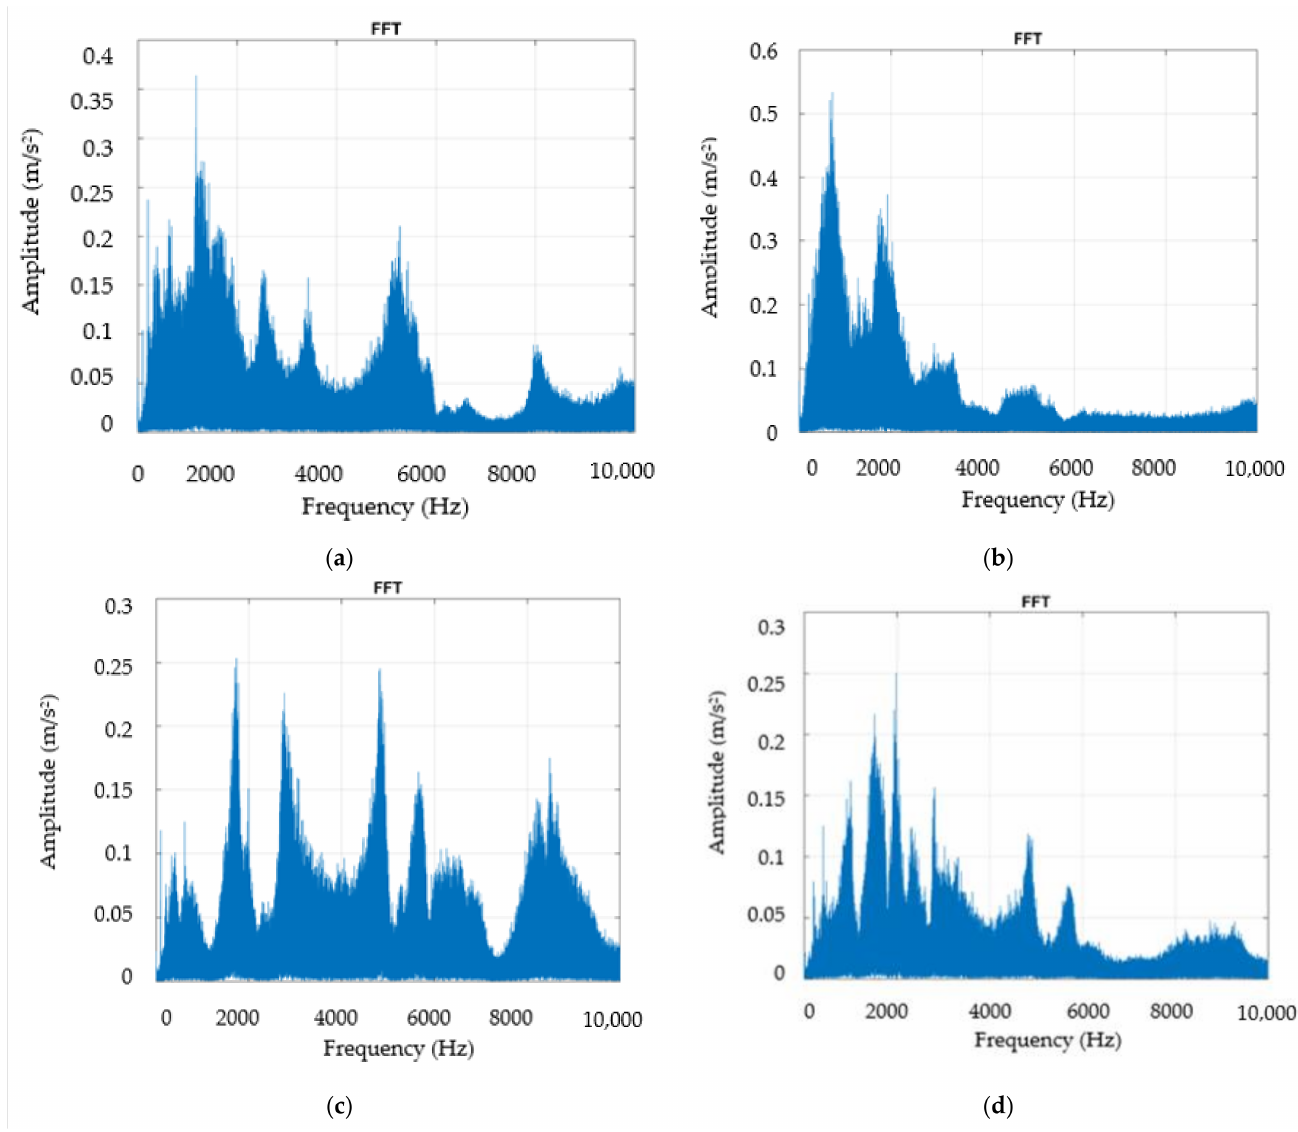
Figure 6. Vibration analysis by applying FFT: ( a ) in the Z direction, in the case of machining with a cutting tool T01; ( b ) in the Y direction in the case of machining with a cutting tool T01; ( c ) in the Z direction in the case of machining with the cutting tool T02; ( d ) in the Y direction in the case of machining with a T02 cutting